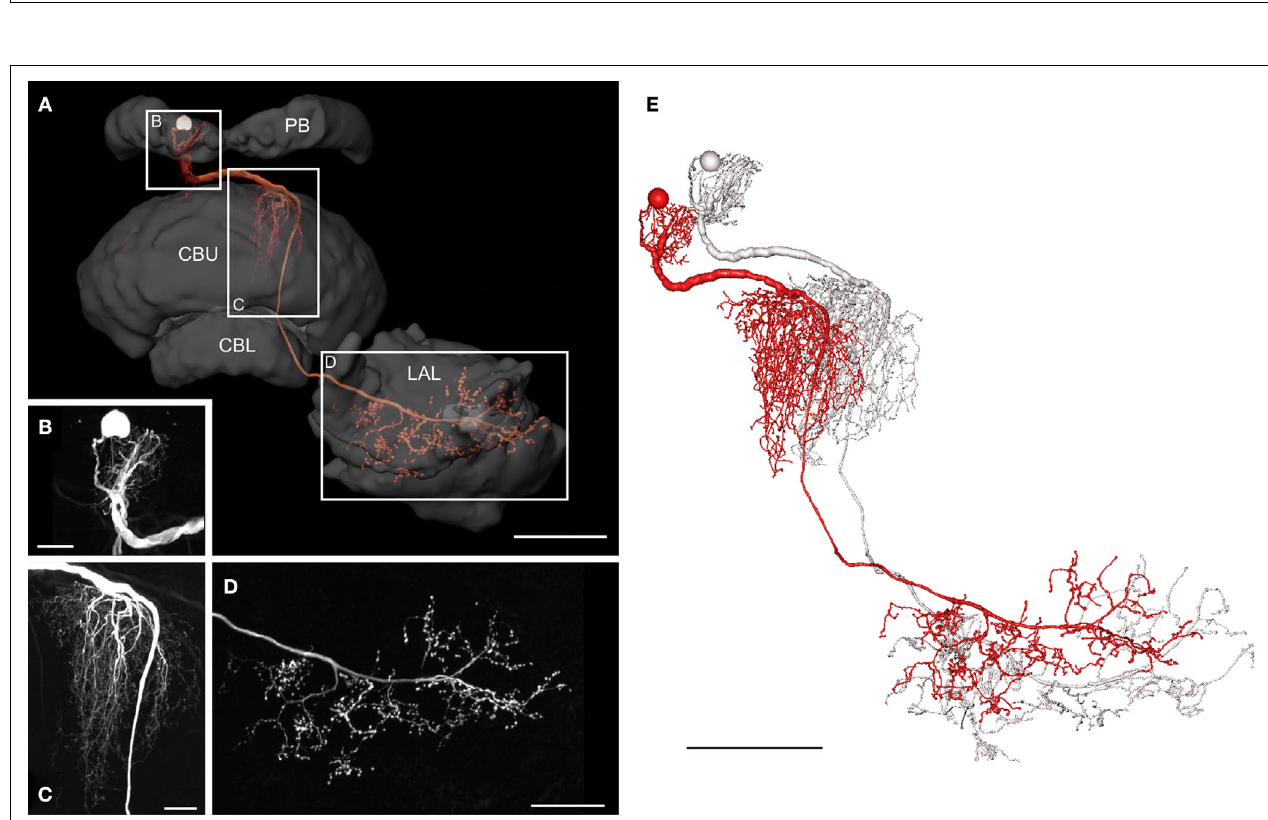
standard error; *** p < 0.001; ** p < 0.01; ns, not signifi cant). (B) Comparison of neuropil sizes in the ISA standard brain and in the ISA standard central complex. CBL, lower division of the central body; CBU, upper division of the central body; No, noduli; PB, protocerebral bridge; x, y, z neuropil sizes in x , y , and z directions.